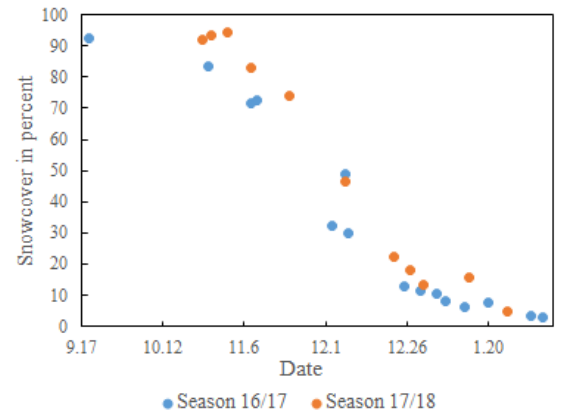
Figure 14. Season 2016/17 and 2017/18: snow cover. Percent equals total land area in the survey area.